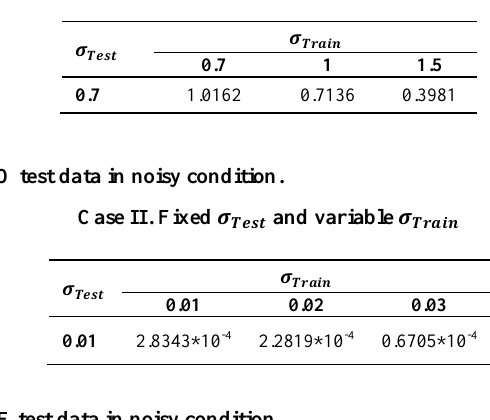
Table 7. MSE of model for BE test data in noisy condition.